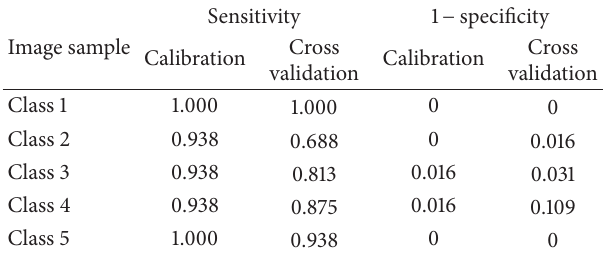
Table 2: Sensitivity and 1 − specificity values of classification model using